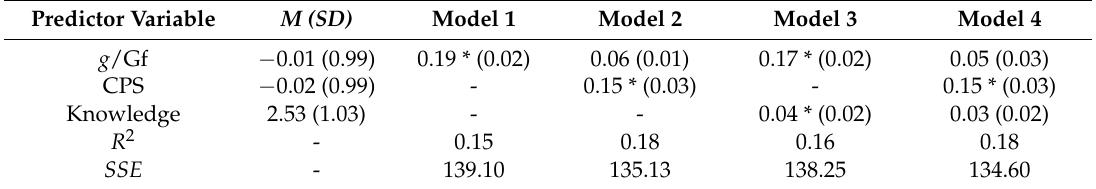
Table 3. Regression models pooling over job zones (DV: natural log median annual wages, ln). Predictor Variable M (SD) Model 1 Model 2 Model 3 Model 4 g /Gf − 0.01 (0.99) 0.19 * (0.02) 0.06 (0.01) CPS − 0.02 (0.99) - 0.15 * (0.03) Knowledge 2.53 (1.03)